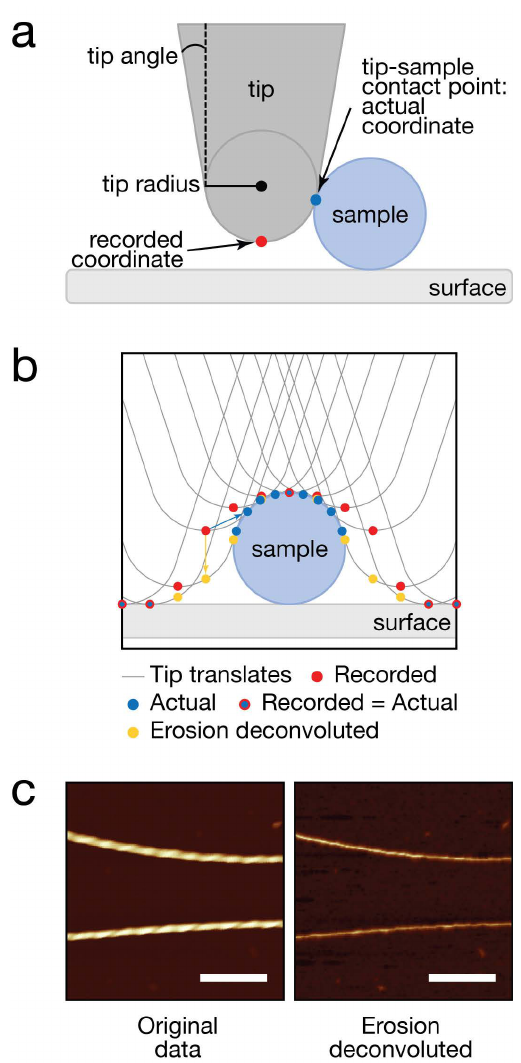
Figure 1: AFM image deconvolution by the erosion algorithm corrects for dilation but causes significant loss of structural information of the sample surface. (a) Schematic cross-sectional illustration of AFM tip-sample interactions that lead to lateral convolution and dilation of sample features. This imaging artefact is especially pronounced for sample objects on the same size range as the tip radius. (b) Schematic cross-sectional diagram of tip-sample deconvolution by erosion. The sample cross-section is illustrated as a blue circle. Red dots show original coordinates of the data, orange dots show erosion deconvoluted height coordinates at each pixel location and blue dots show the coordinates at tip-sample contact points for each pixel location. (c) Example of deconvolution by the erosion algorithm demonstrated on an example image of a twisted amyloid fibril. Left is an AFM topology image showing twisted amyloid fibrils. Right image shows the erosion-deconvoluted image of the same data, demonstrating substantial loss of structural information due to the erosion algorithm. A symmetric conical tip with a side angle of 18° (estimated from the tip geometry information provided by the manufacturer) and tip radius of 11.2 nm (estimated using the image features as described in the Results) was used as a model of the tip. The scale bars represent 200